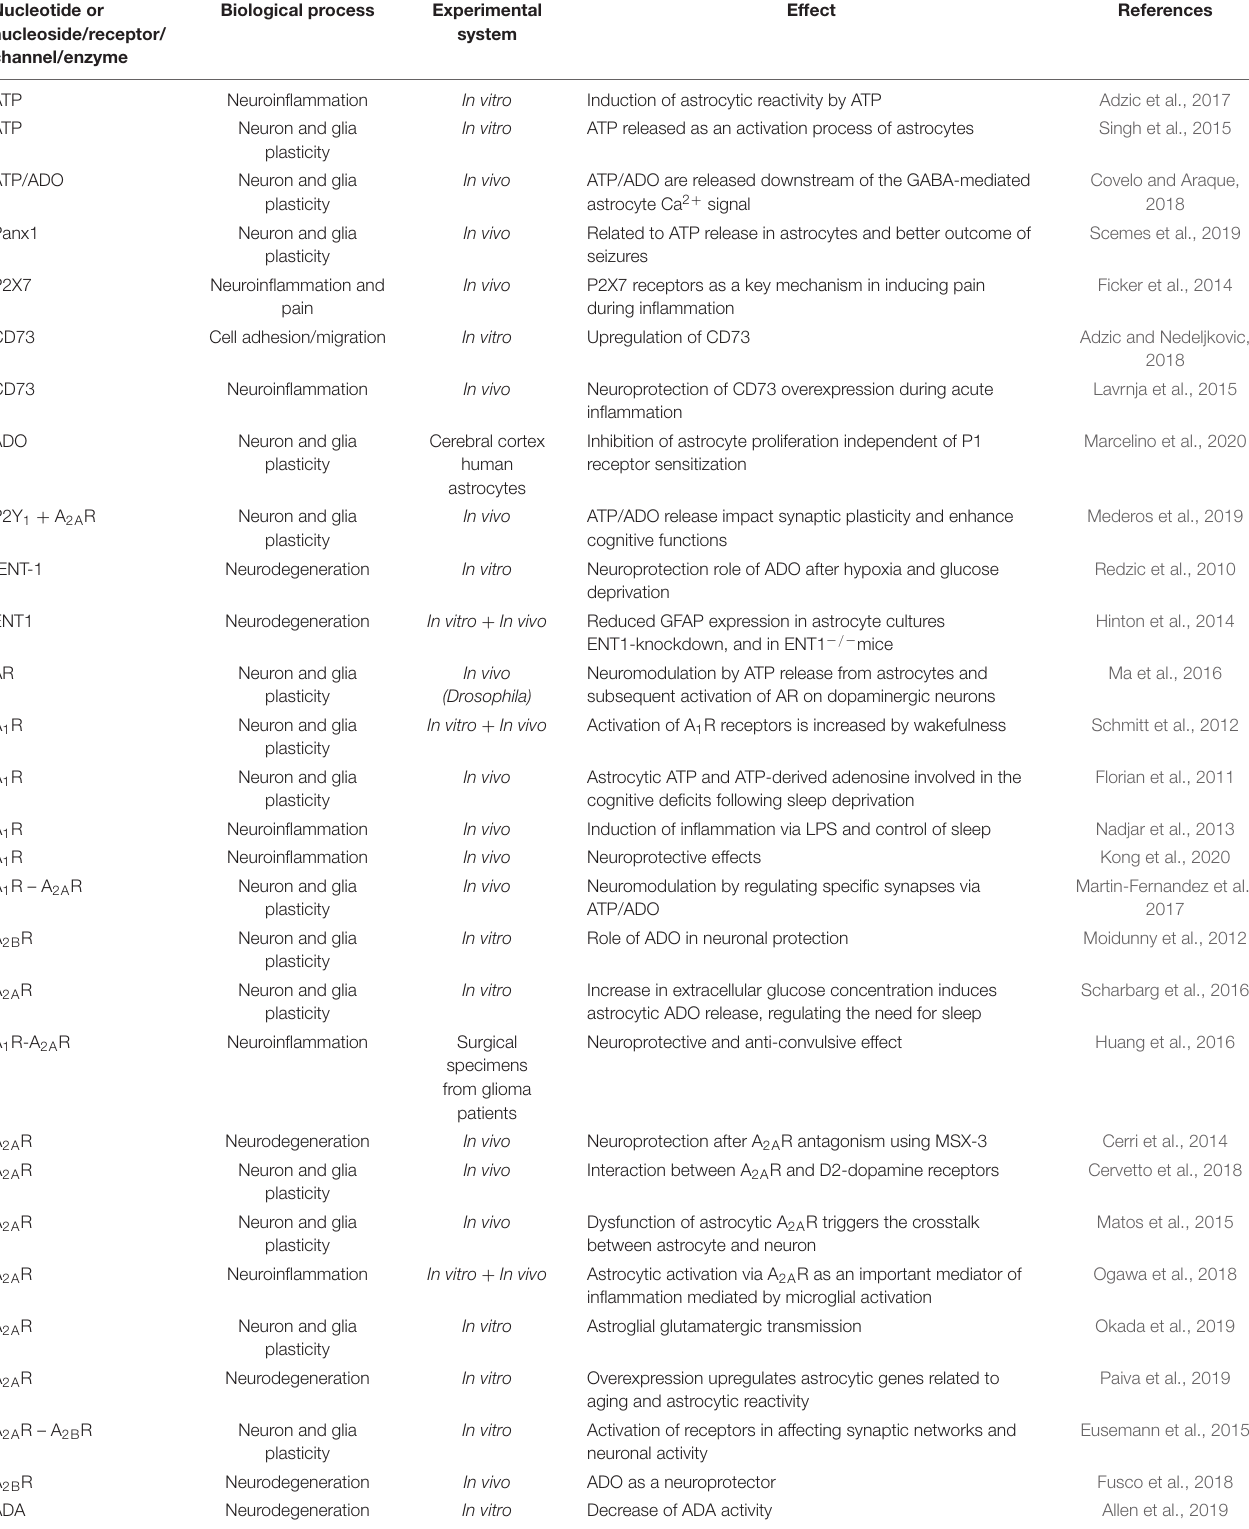
TABLE 1 | Purinergic signaling in